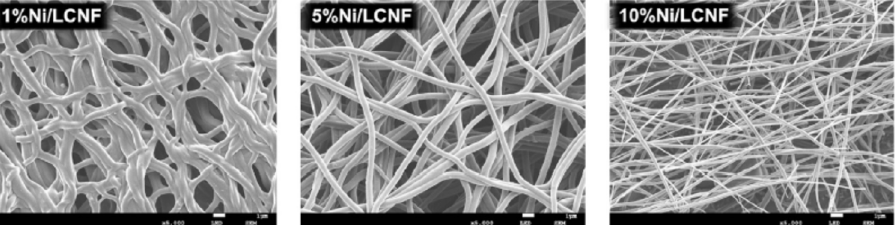
Figure 29. SEM images of the catalyst (based on nickel deposited on lignin-based carbon nanofiber) used by Wang and Zhou et al. for lignin depolymerization [172].